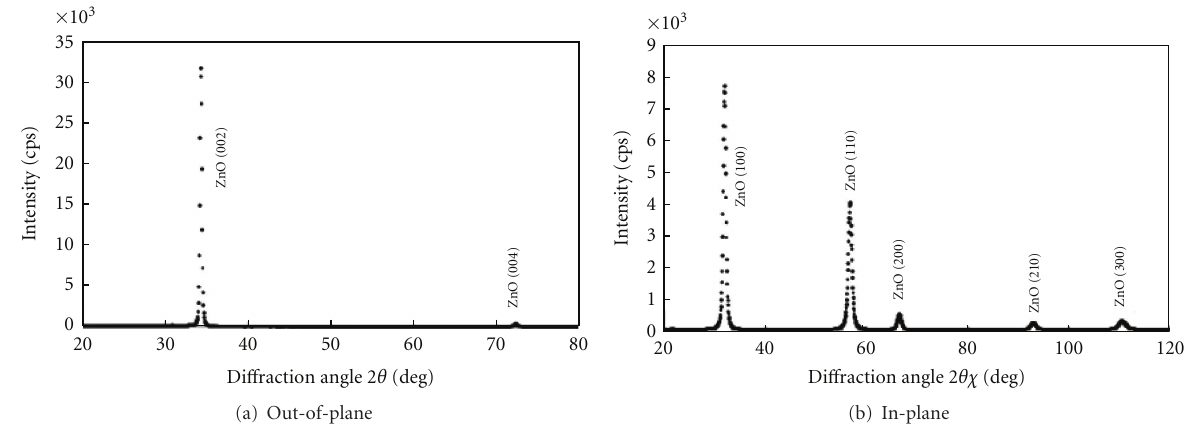
Figure 8: Typical XRD profile of a GZO film with 150 nm thickness prepared at 180 ◦ C using the RPD system. Profiles (a) and (b) were obtained using out-of-plane and in-plane techniques for XRD measurements, respectively.